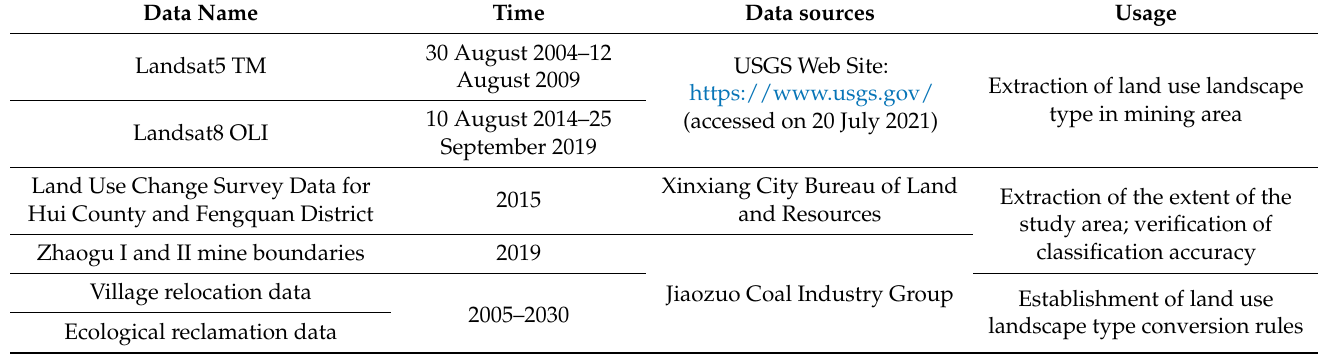
Table 1. Basic information of the research data.